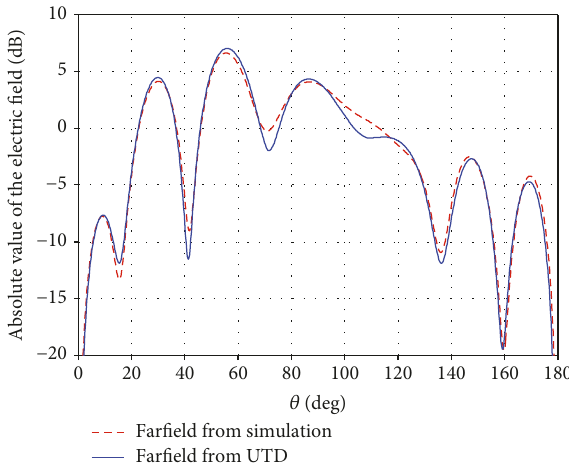
Figure 8: Amplitude of electric fi eld of the ϕ component in the ϕ =20 ° plane with w =4 λ and h =1 λ , at 4 GHz compared with simulation result.